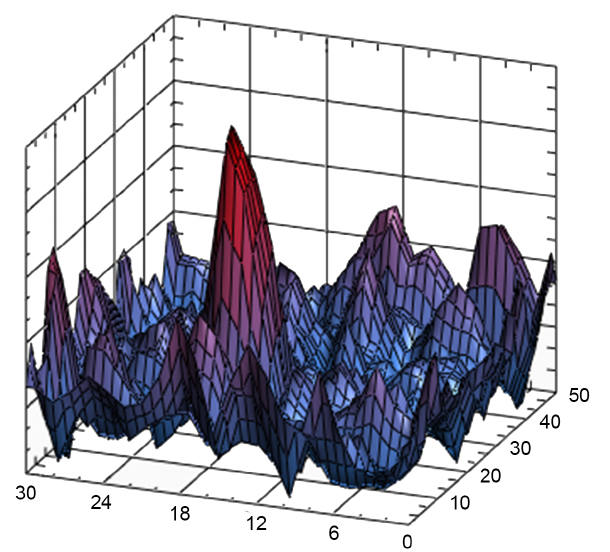
Figure 13. The 2D map of the R max